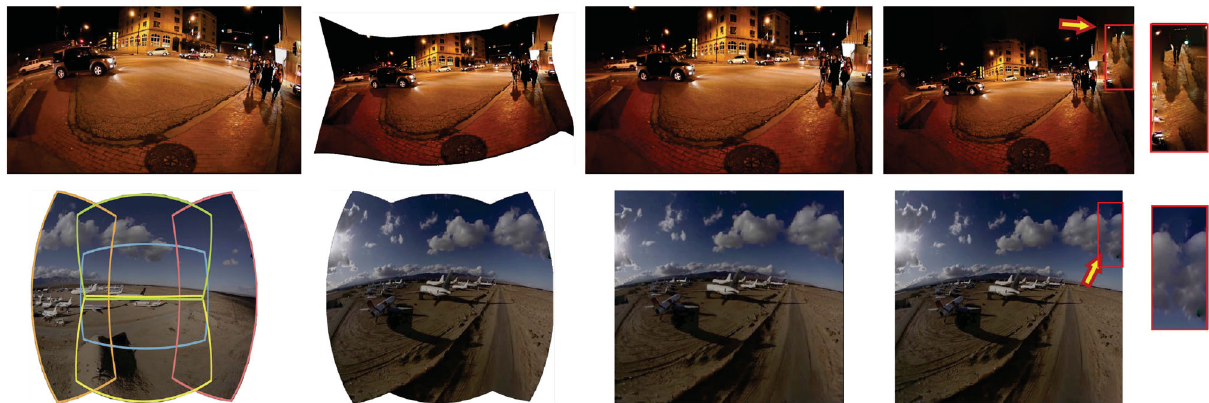
Fig. 1 Irregular videos. Above: shape-corrected fish-eye video frame using Ref. [3]. Below: panorama video frame using Ref. [6]. 3rd column: rectangling results using our approach. 4th column: results using a video completion